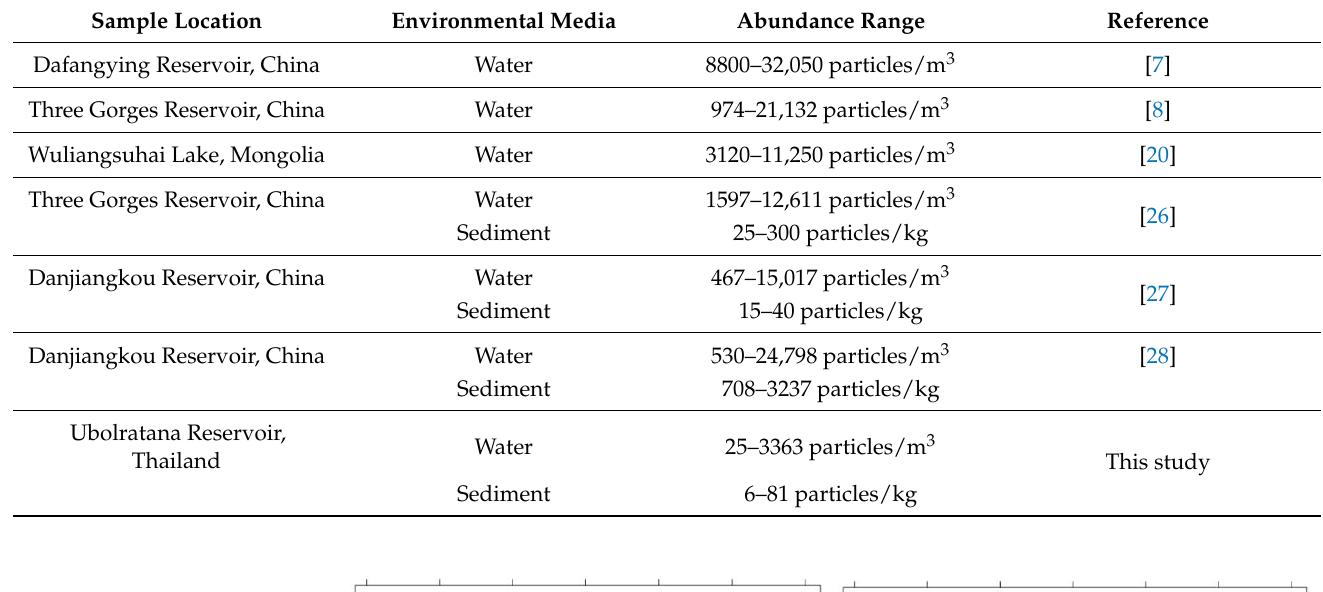
Table 1. Previous studies detailing microplastic abundance in reservoirs.